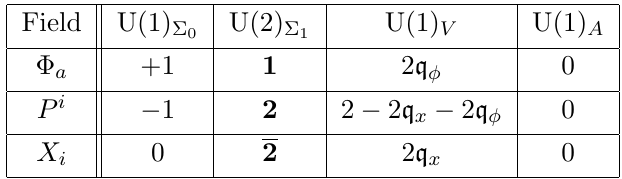
and U(2) (cid:6) gauge group representations, U(1) V and U(1) A R-charge 0 1